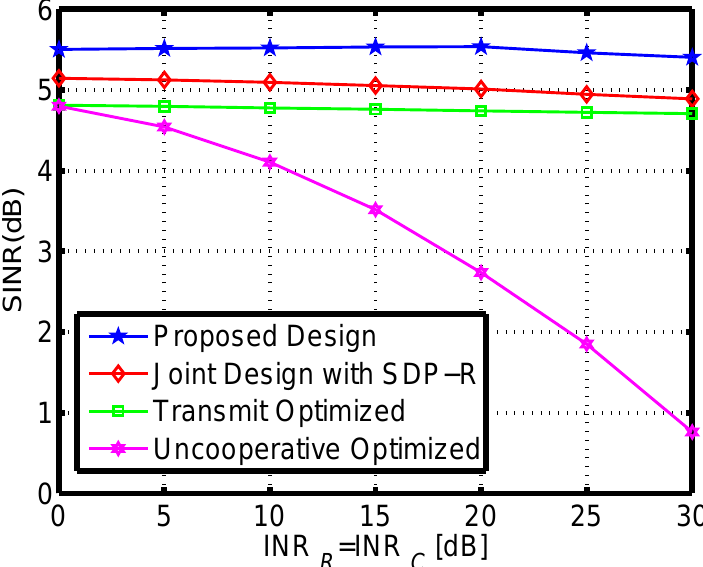
Figure 6. The radar SINR under different INR R = INR C of mutual